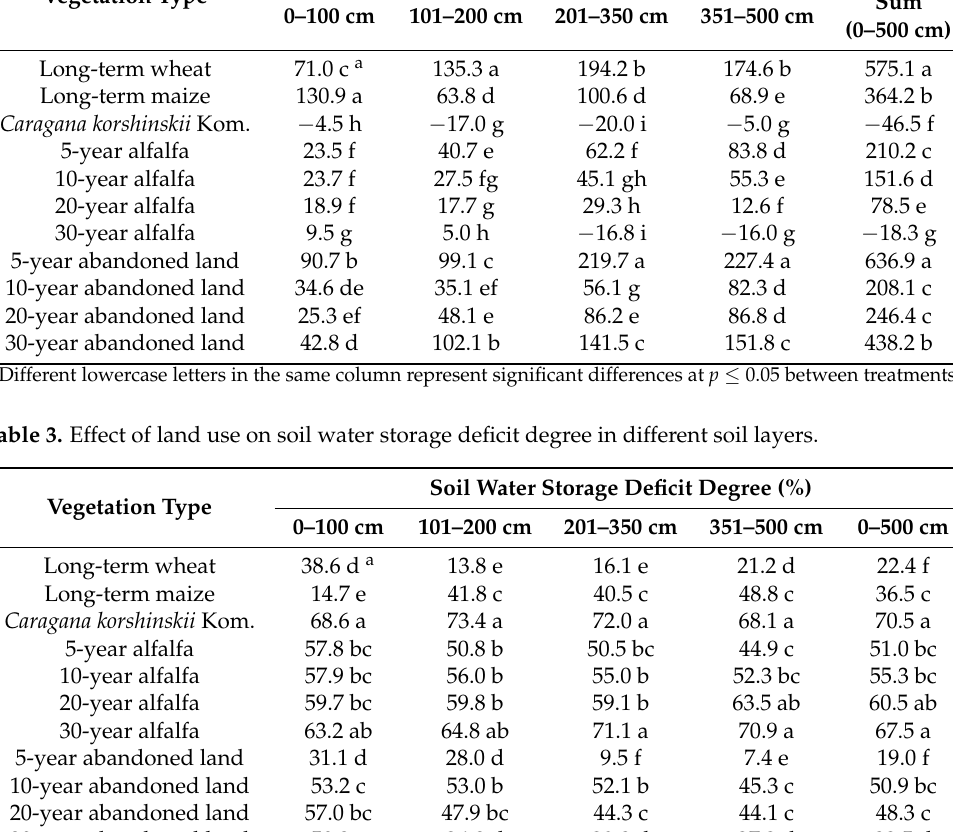
Vegetation Type